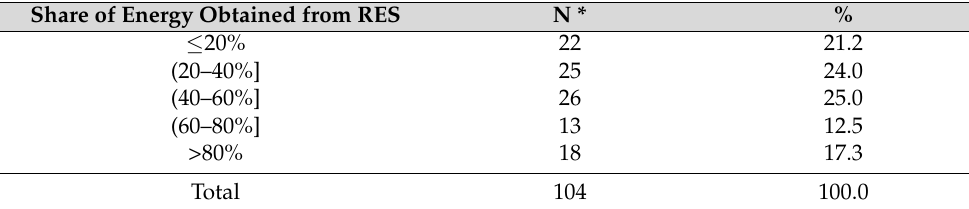
Table 4. Share of energy from renewable energy sources in total household energy consumption. N = 104. Share of Energy Obtained from RES N *